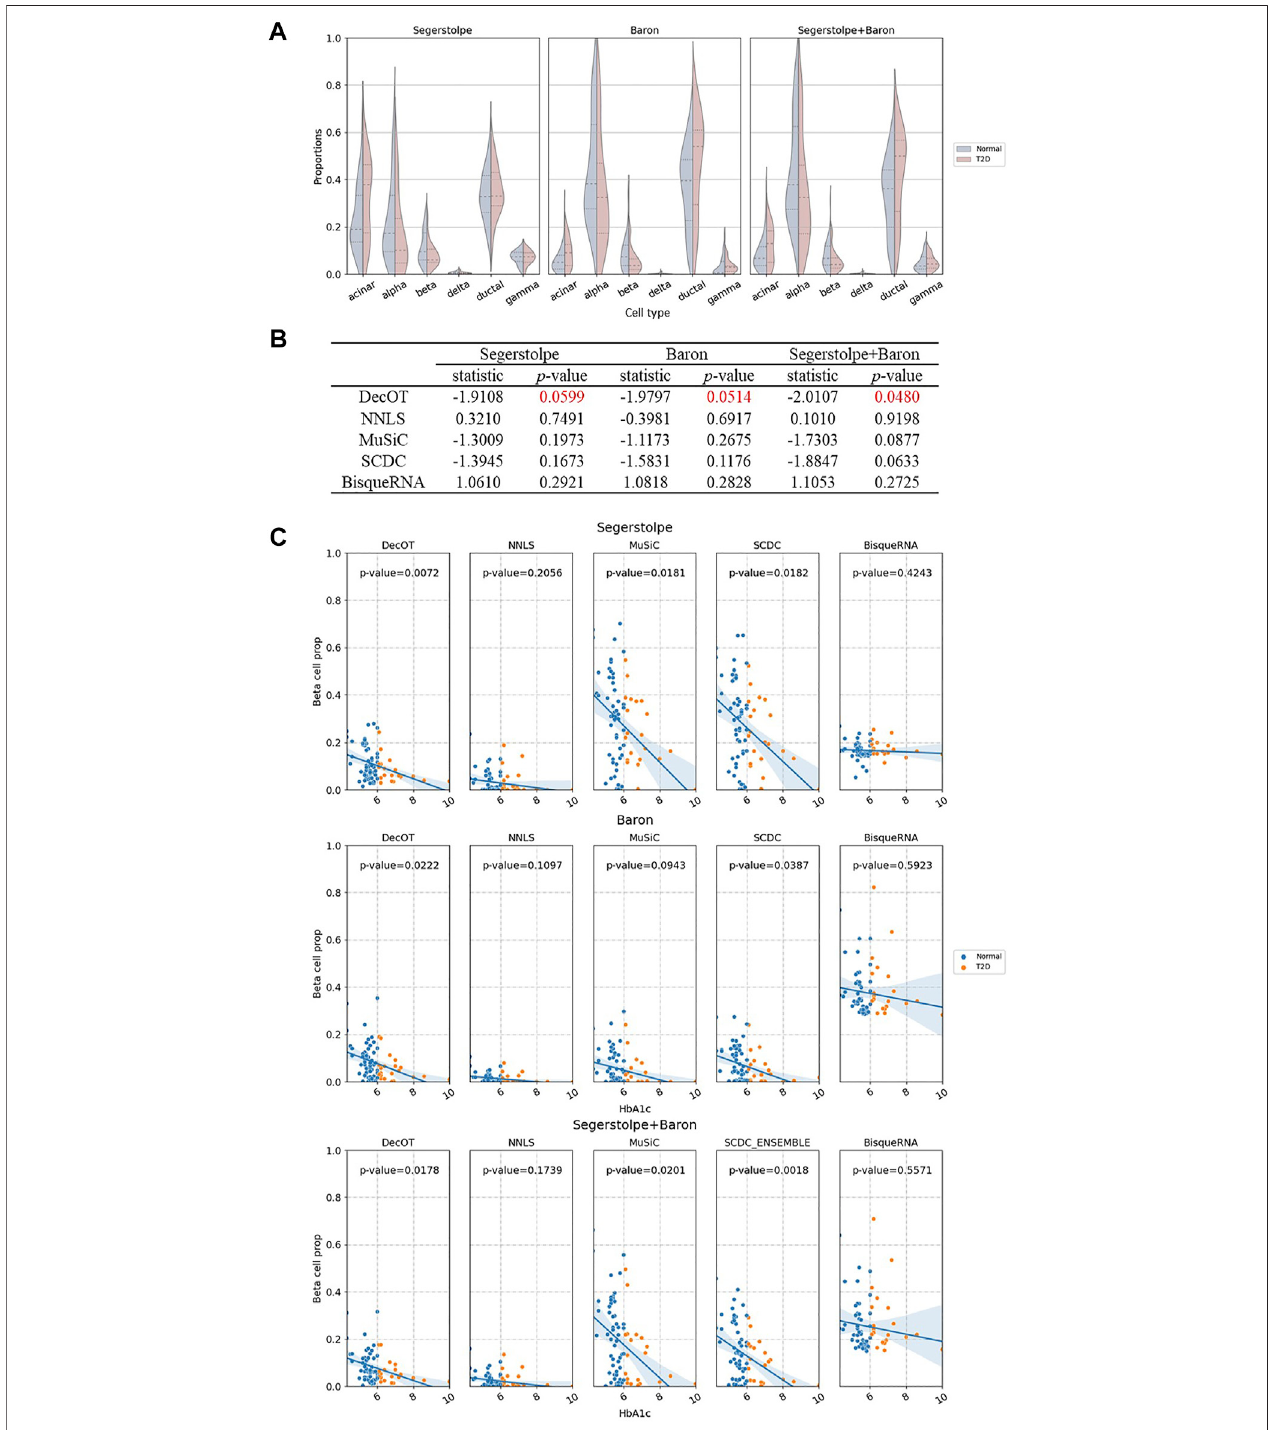
FIGURE4| Cell-typedeconvolutionofhealthyandT2Dhumanpancreaticisletsamples. (A) Estimatedcompositionofisletcelltypesinhealthyandtype2diabetes (T2D)humansbyDecOTunderthreesettingsofreferences.TheviolinplotsshowtheproportiondifferencesbetweenhealthyandT2Dsamples. (B) Independentsample t-testsofbetacellproportionbetweenhealthyandT2Dindividuals.DecOTshowsthemostsigni fi cantdifferenceascomparedtoothermethods. (C) Linearregressionof HbA1c expression level and the proportion of beta cells estimated by fi ve methods. The reported p -values come from a multivariate linear regression model: beta cell ratio ~ HbA1c + age + BMI +